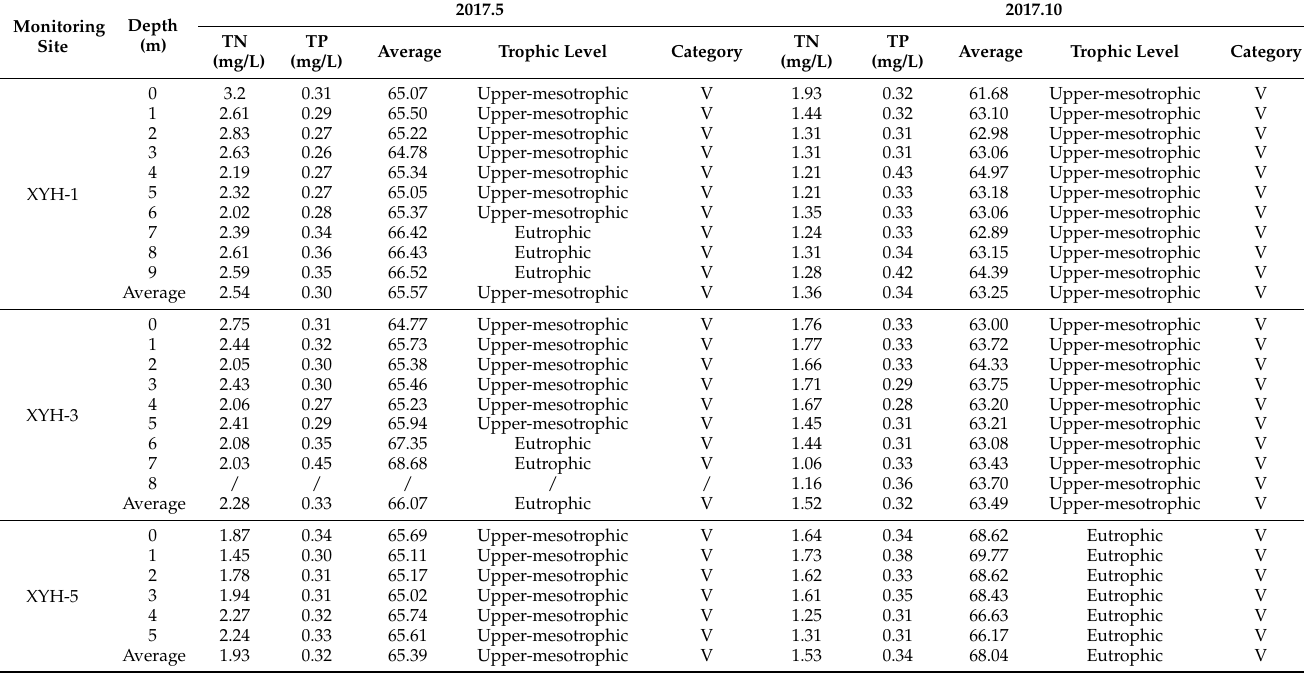
Table 4. The evaluation table of water quality in Lake Xingyun in